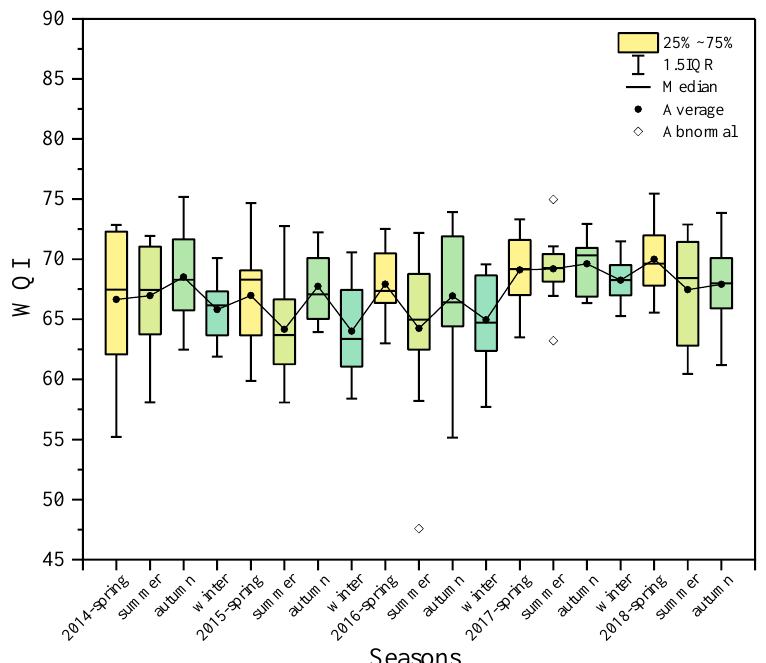
Figure 3. Seasonal variations in the WQI in the SNWDPC-ER (spring, summer, fall, and winter correspond to March–May, June–August, September–November, and December–February, respectively; yellow: spring, yellow-green: summer, blue-green: autumn, blue: winter).